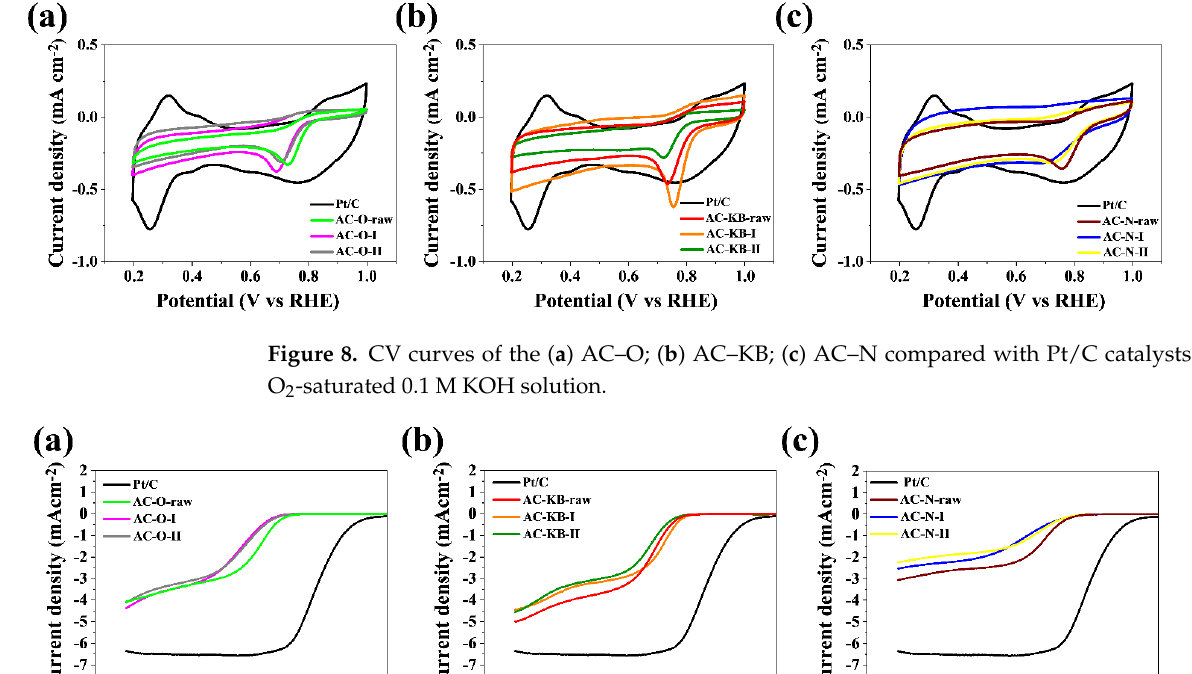
Figure 9. LSV curves of the ( a ) AC–O; ( b ) AC–KB; ( c ) AC–N compared with Pt/C catalysts, at a scan rate of 5 mV s –1 and a rotation rate of 1600 rpm in O 2 -saturated alkaline media.